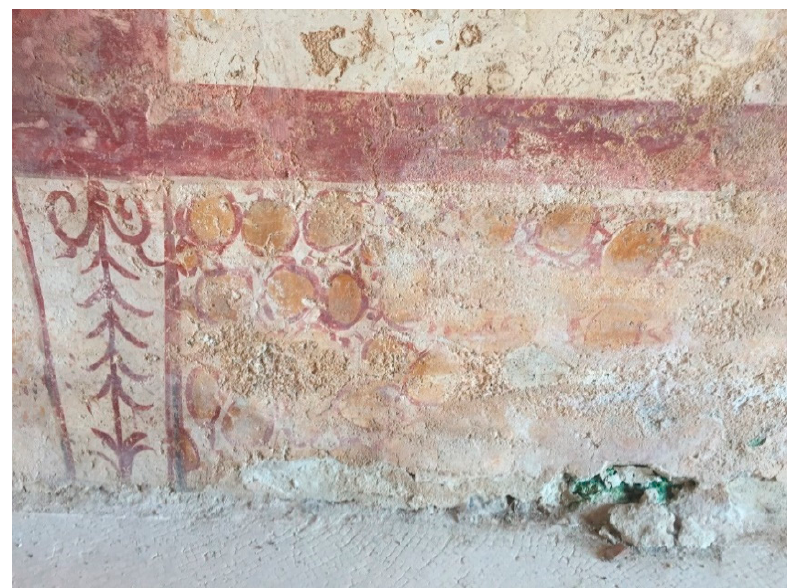
Figure 12. Soluntum, House of Leda, triclinium g, detail of faux Numidian yellow marble block from the dado (photo by the author).